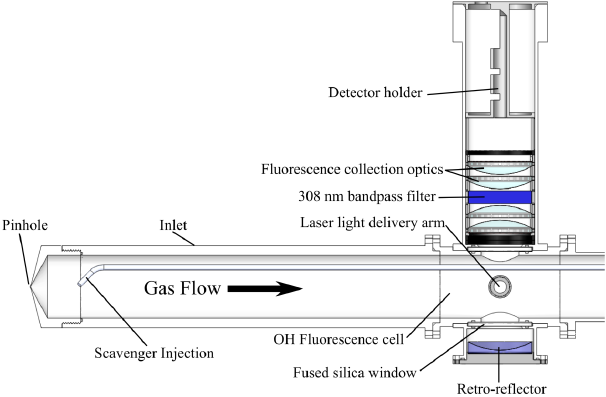
Figure 1. Schematic showing a side-on vertical cross section of the HIRAC FAGE OH fluorescence cell. The OH scavenger ( iso - butane) was introduced ∼ 40mm from the inlet pinhole through an 1 / 8in. internal-diameter stainless-steel tube mounted in between the OH and HO 2 cells (out of frame). The tube ran flush to the cell wall to reduce possible scattering of laser light, and the tip was angled slightly towards the centre of the main gas flow to improve